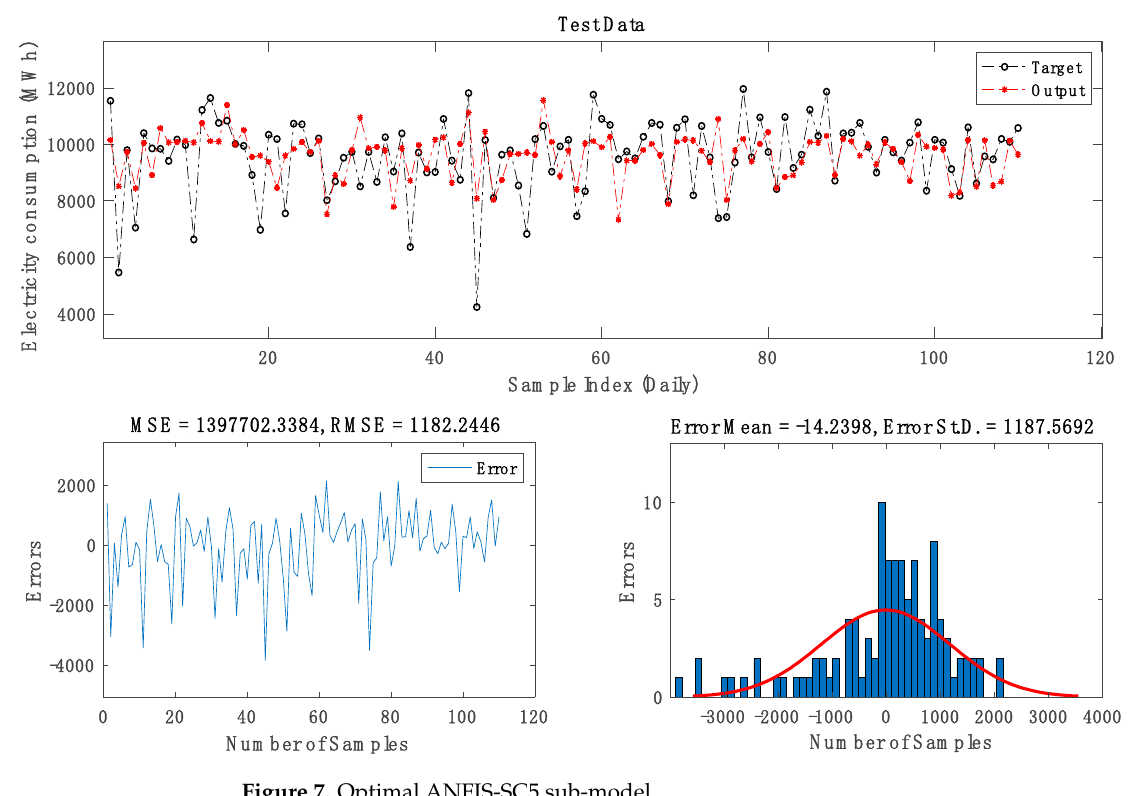
Figure 6. Optimal ANFIS-GP4 sub-model.